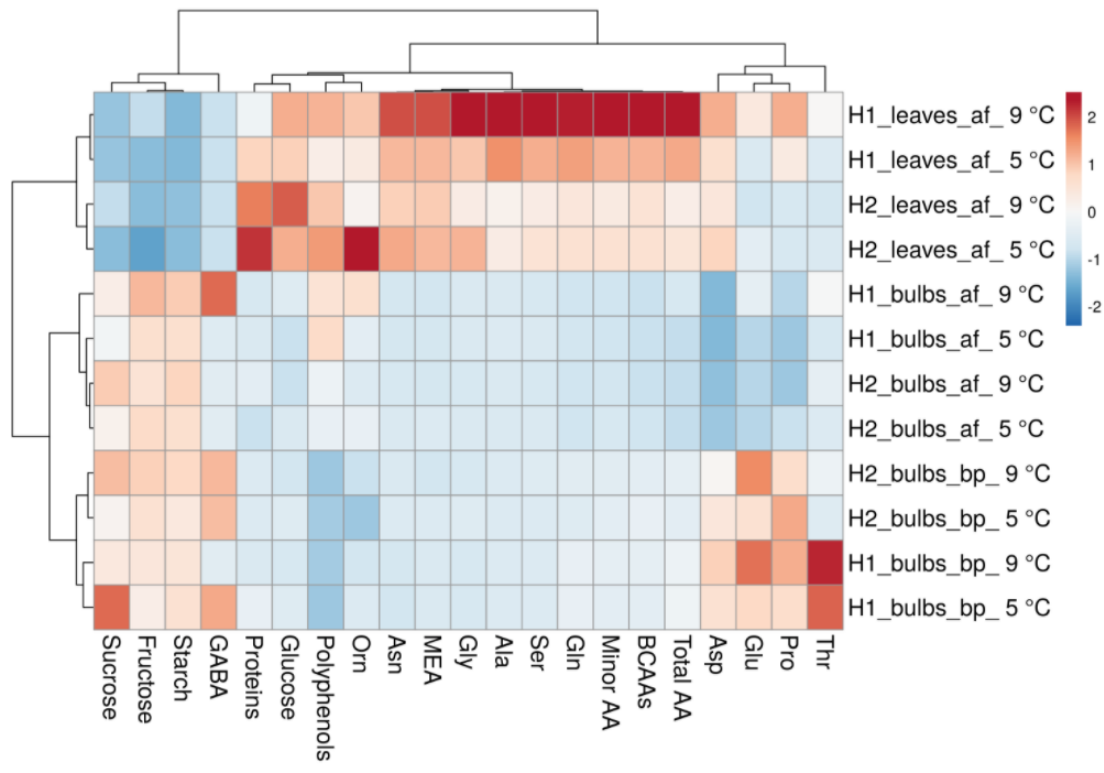
Figure 1. Cluster heat map analysis summarizing the changes in the metabolic profile of bulbs before planting and at flowering and leaves at flowering of the two hybrids of Tulipa gesneriana L. ‘Royal Virgin’ and ‘Ad Rem’, grown hydroponically from bulbs subjected to two preparation procedures, 5 °C and 9 °C. The cluster heat map was generated using the https://biit.cs.ut.ee/clustvis/ (accessed on 12 March 2022) online program package with Euclidean distance as the similarity measure and hierarchical clustering with complete linkage.